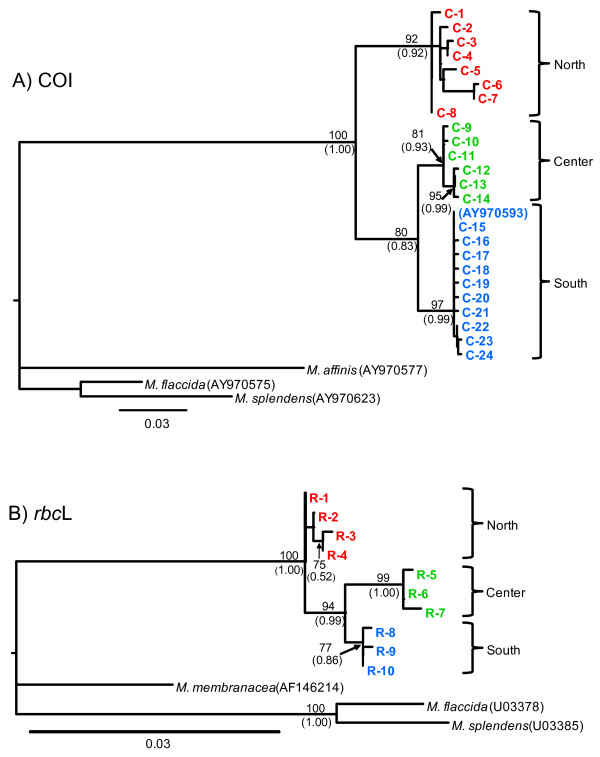
Maximum likelihood rooted trees for COI (A) and rbcL (B) haplotypes of M. laminarioides . Maximum likelihood bootstrap values are indicated above each node and Bayesian posterior probabilities are noted between brackets. Only high support values are shown (>75 for bootstraps and >0.75 for posterior values, respectively).